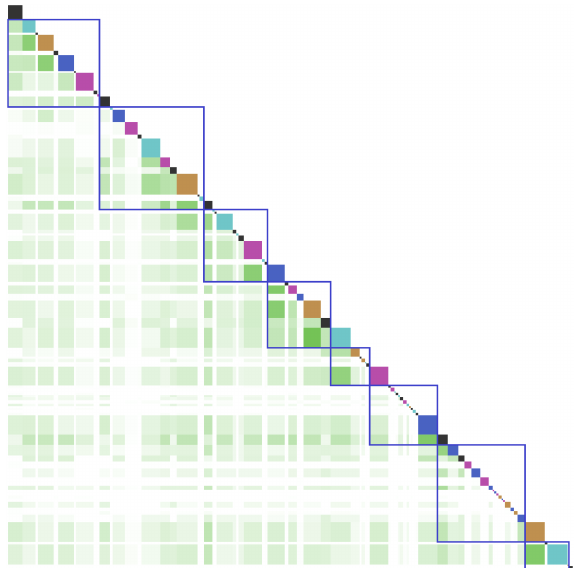
Figure 30. Result of topic segmentation after doubling the weights of all debate consistency metrics in the direction of improved internal consistency.